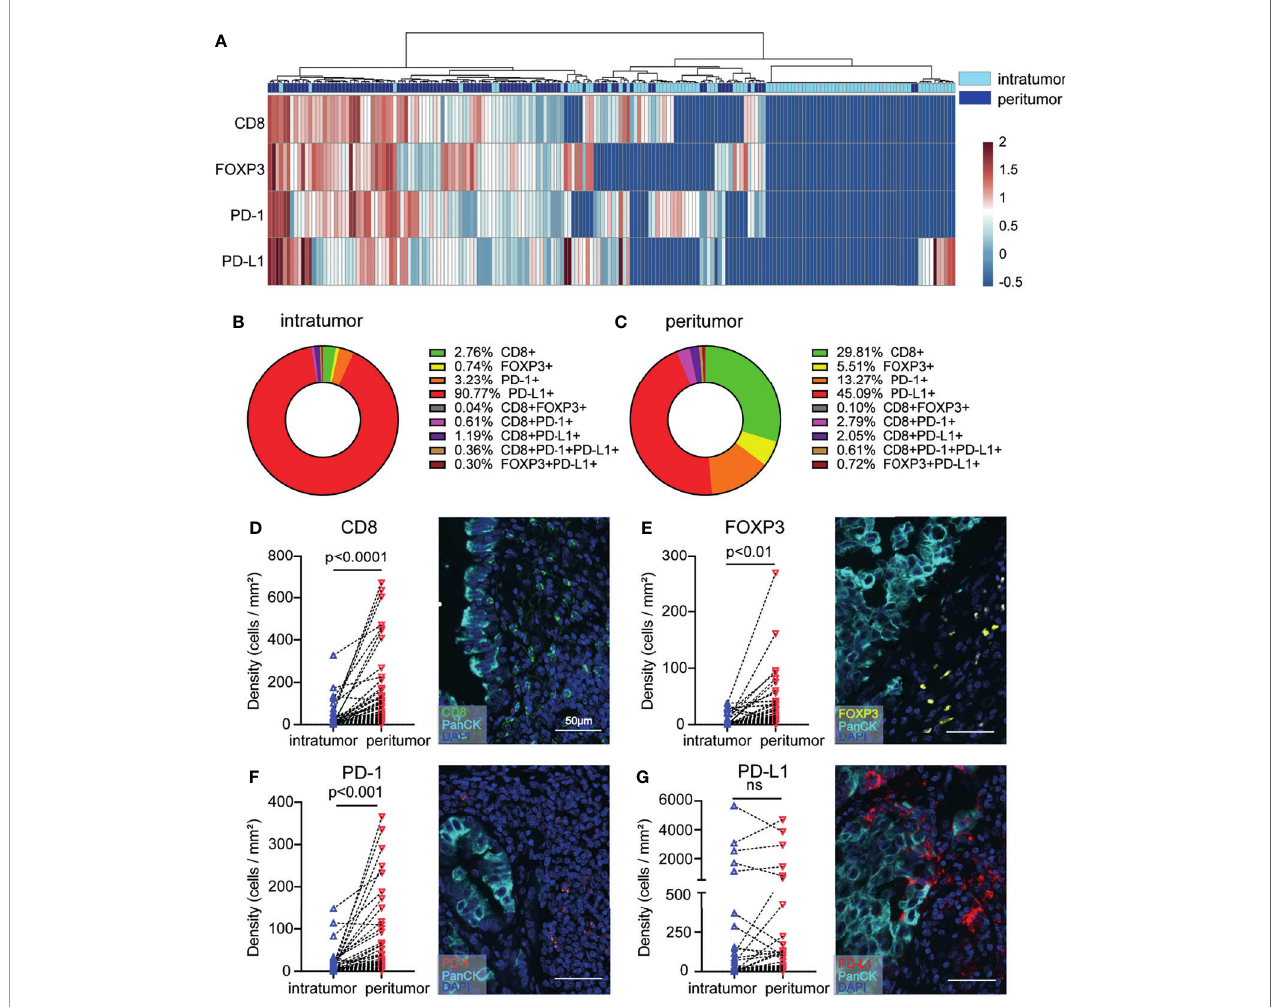
FIGURE 3 | NSCLC tissue samples display increased in fi ltration of heterogeneous T cell subpopulations in the peritumoral subregion. (A) Heatmap representation of the results of the hierarchical clustering showing the densities of CD8+, FOXP3+, PD-1+, and PD-L1+ cells and a dendrogram of the results of the unsupervised hierarchical clustering of peritumoral and intratumoral tissues. (B, C) The distribution of each immune cell subpopulation in peritumoral and intratumoral tissues. (D – G) Differences in immune cell density according to the sampling strategy. The y-axis represents each immune cell density. The x-axis of each point is labeled with the peritumoral and intratumoral sampling strategy. Lines connect the two points of the densities of each marker relating to the same tumor. Representative images are shown on the right. Paired t tests were used to assess differences, and p values are